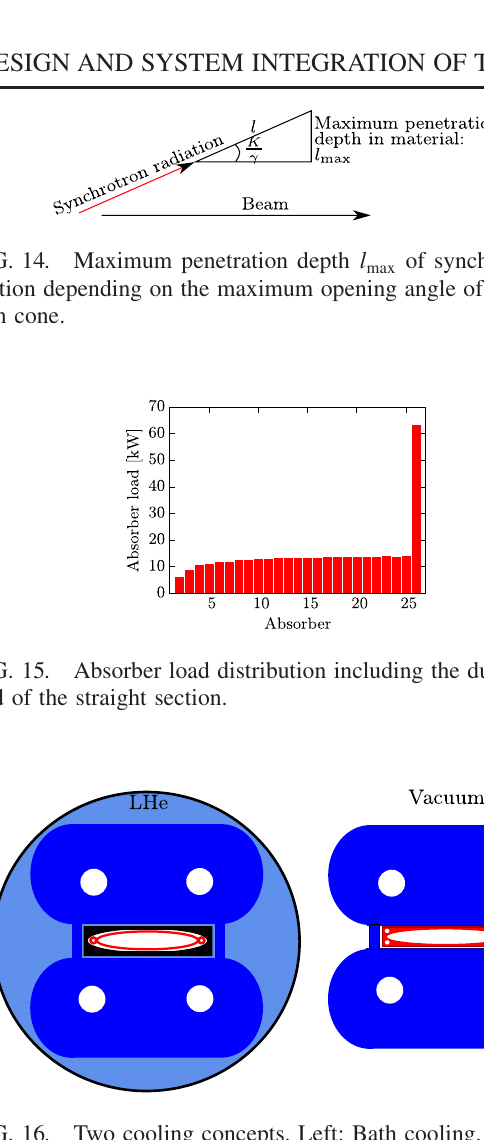
FIG. 16. Two cooling concepts. Left: Bath cooling. The mag- net is immersed in liquid helium (LHe). Right: Indirect cooling. The whole wiggler magnet is in vacuum. The helium is contained in the heat exchangers.